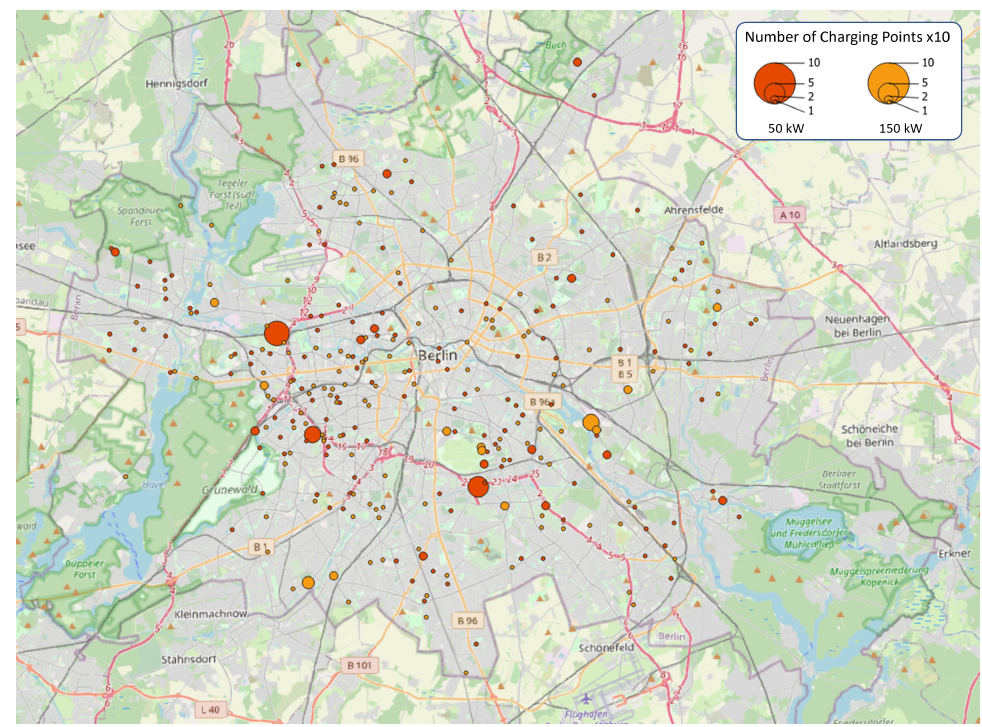
Figure 9. Spatial distribution of public charging infrastructure in bottom-edge solution.